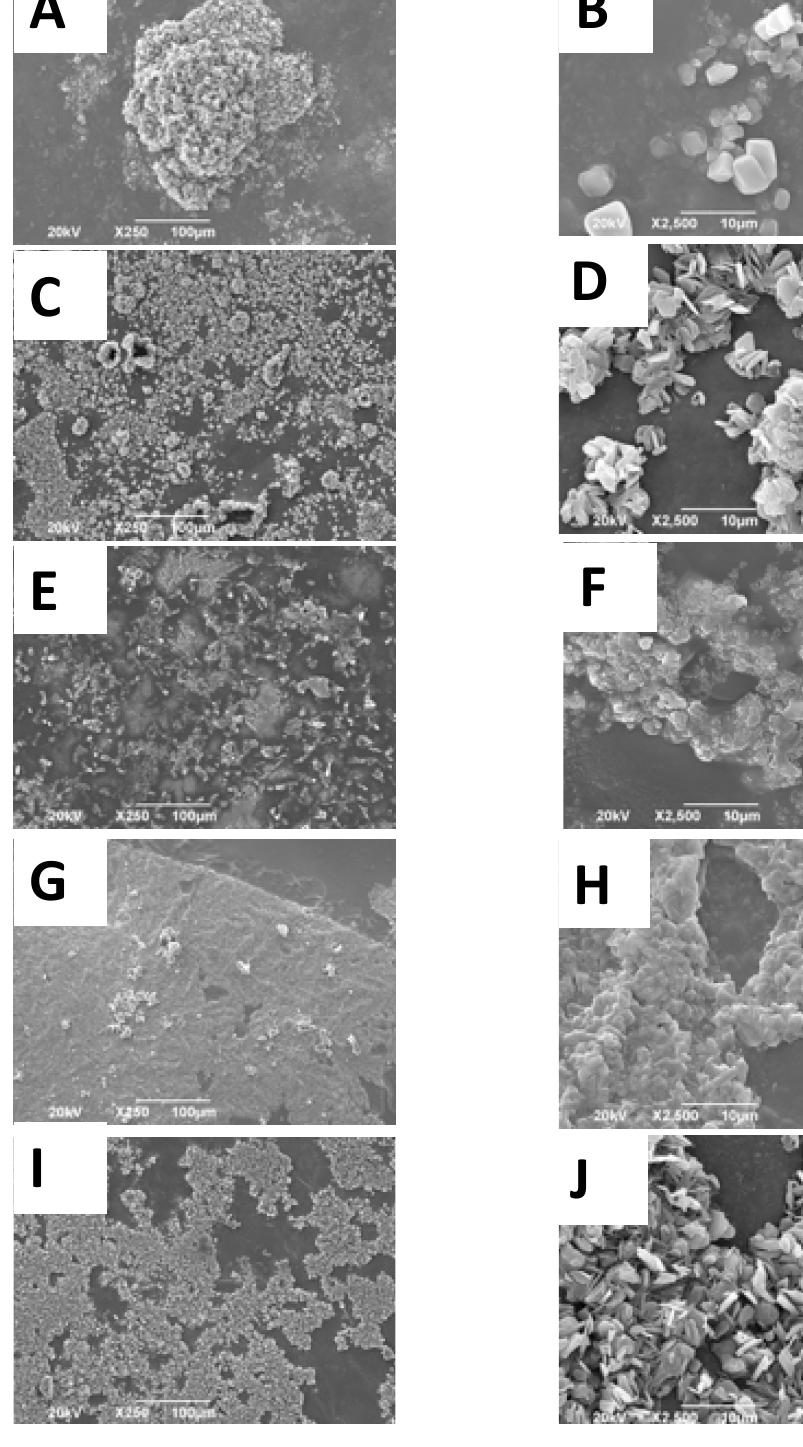
Figure 7. Morphology of CS/PVA/ox-CNO films after 15 days following the degradation process in FBS: F1 (30 CS/70 PVA/0 ox-CNO) ( A ) at 250×, ( B ) at 1000×; F2 (29.75 CS/70 PVA/0.25 ox-CNO) ( C ) at 250×, ( D ) at 1000×; F3 (29.50 CS/70 PVA/0.50 ox-CNO) ( E ) at 250×, ( F ) at 1000×; F4 (29.25 CS/70 PVA/0.25 ox-CNO) ( G ) at 250×, ( H ) at 1000×; F5 (29.00 CS/70 PVA/1.00 ox-CNO), ( I ) at 250× ( J ) at 1000×.